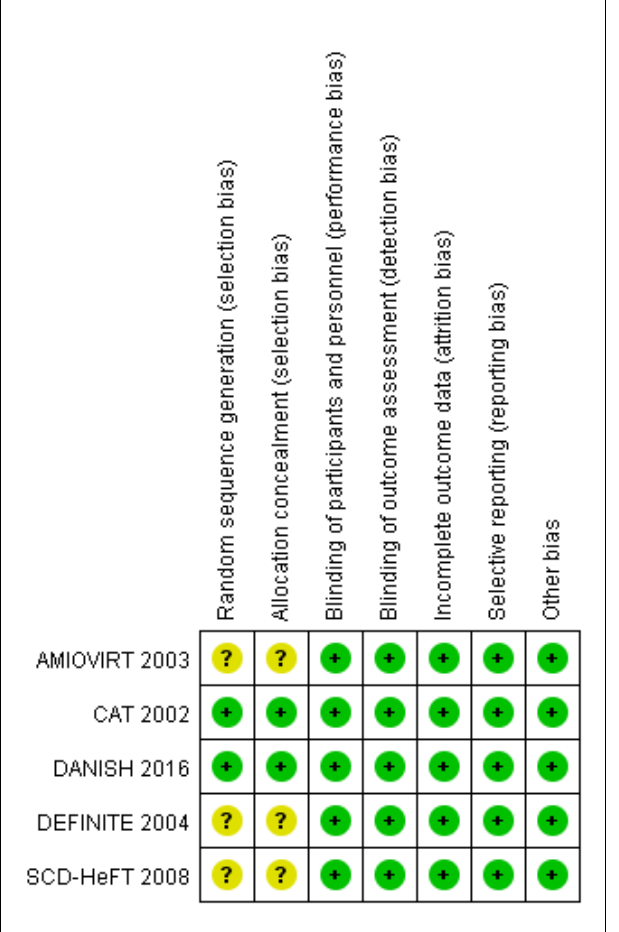
Fig. 2 - Bias assessment using Cochrane Collaboration